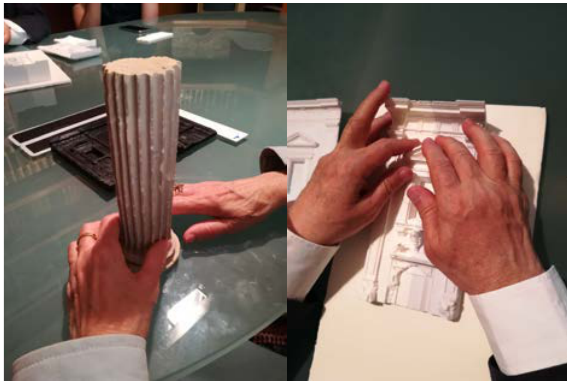
Figure 9. 3D printed model - experiment with a blind